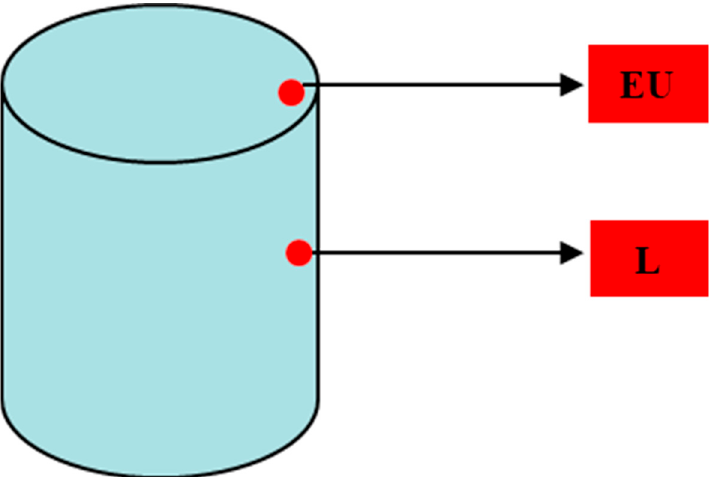
Figure 6. Fourth can thermocouple